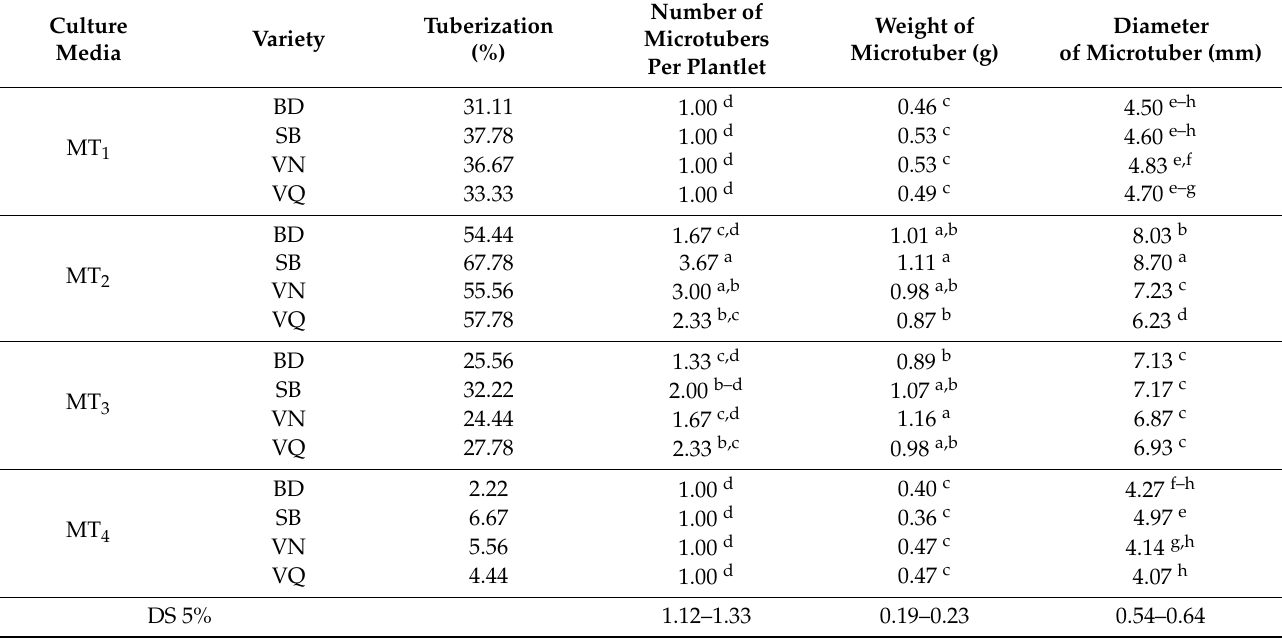
Table 11. Results after microtuberization process of